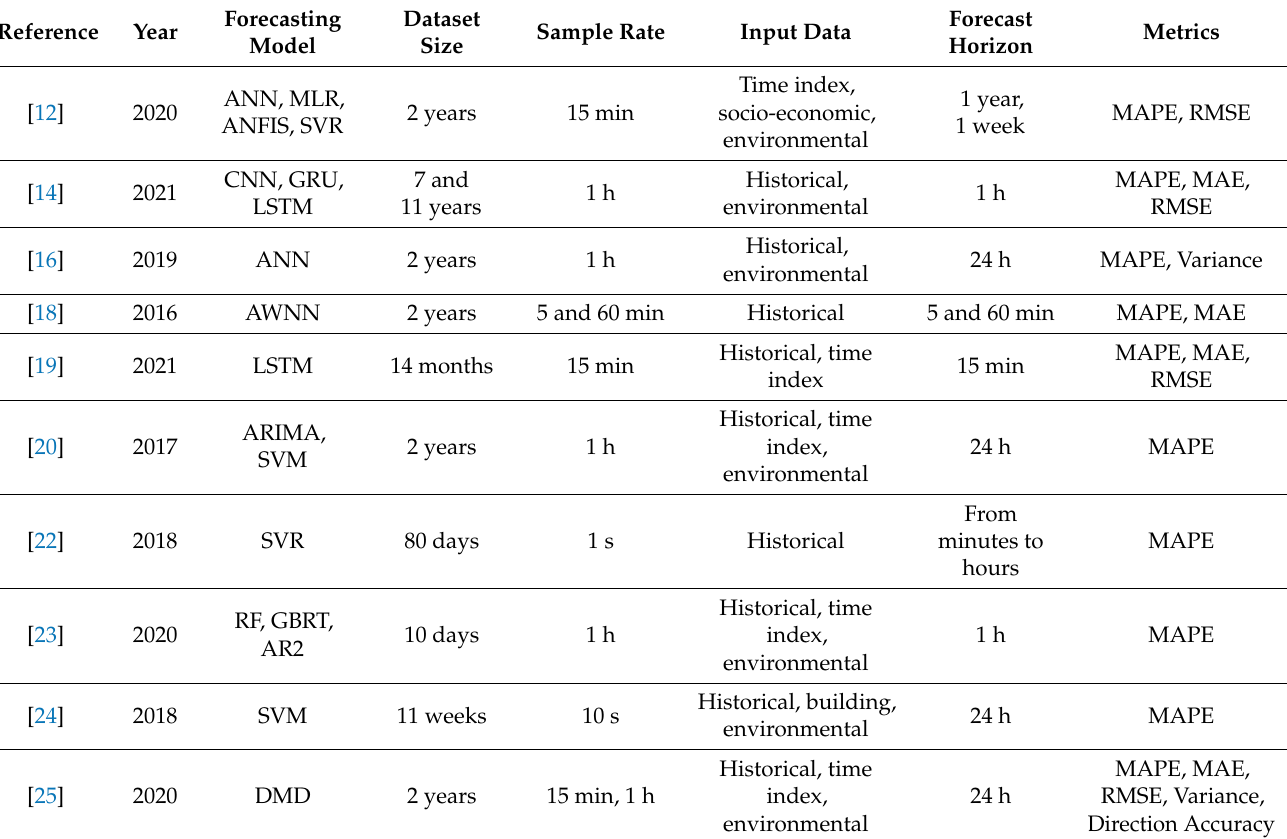
Table 1. Summary of previous